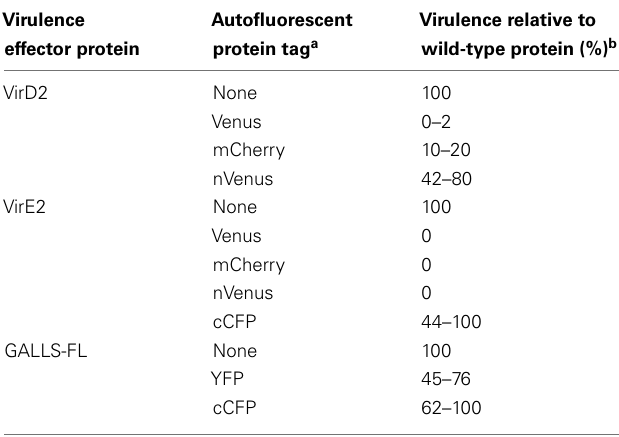
Table 1 | Effect of internally taggingVirulence effector proteins